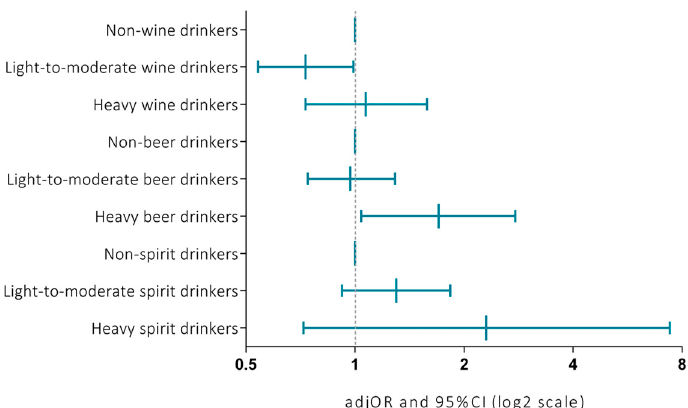
Figure 4. Association of alcohol consumption with poor cardiovascular health status according to beverage choices. This graph shows adjusted odds ratios (ORs) and 95CI% intervals of the association between categories of alcohol consumption and poor cardiovascular health status. Results are based on logistic regression models and adjusted for number of drinking days, age, gender, educational level, and employment status. Non-drinkers of each specific alcoholic beverage were used as reference groups.